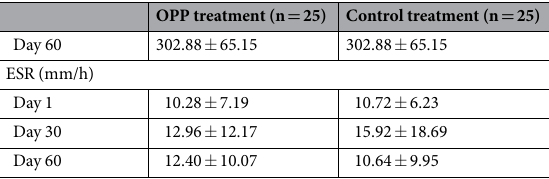
Table 7. Haematology profiles (mean ± SD).